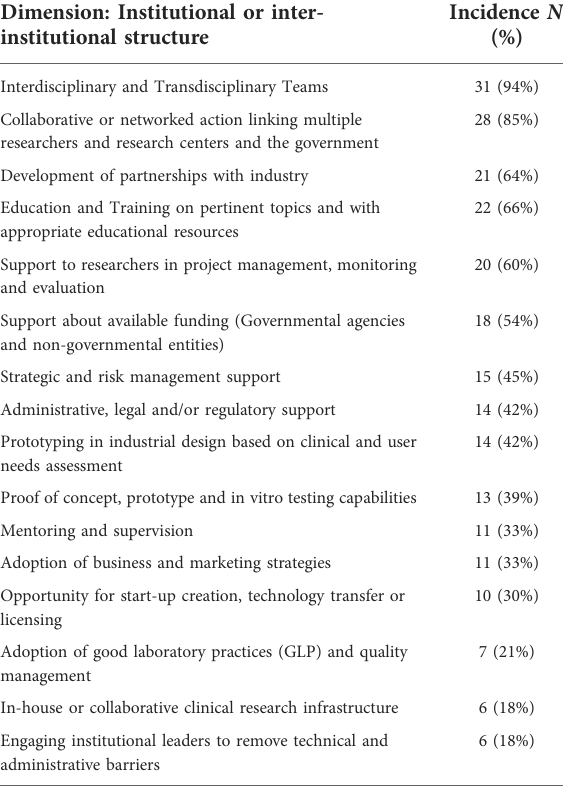
TABLE 2 Incidence of themes related to the attributes of translational research grouped by the capacity dimension. Dimension: Capacity